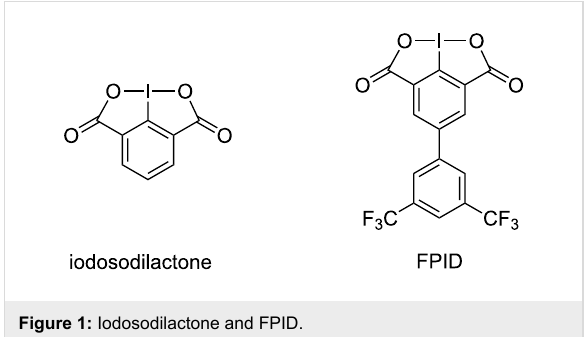
Figure 1: Iodosodilactone and FPID.